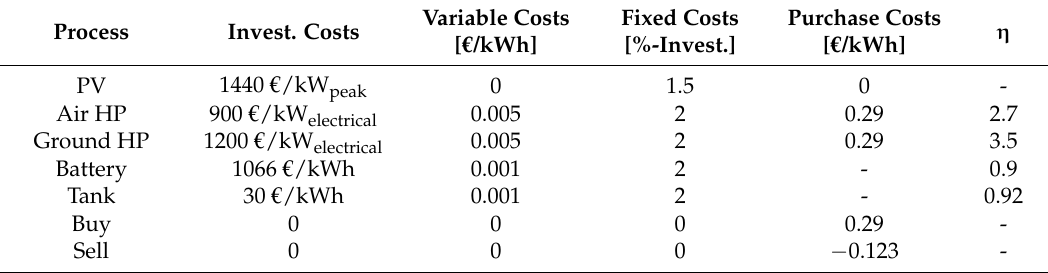
Table 7. Cost parameters for the considered